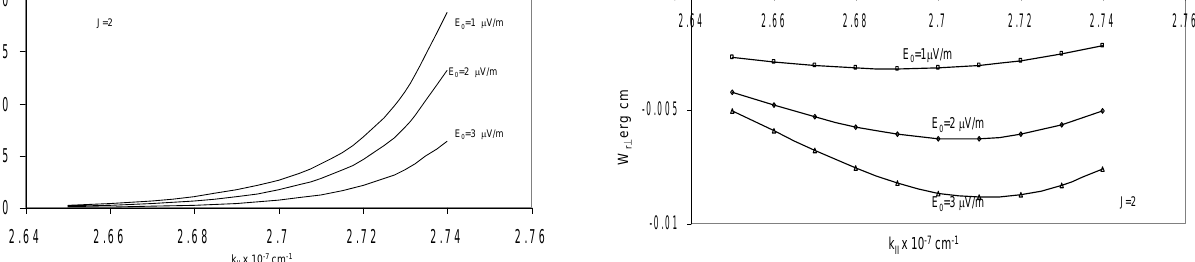
37 40 Fig. 9. Variation of perpendicular resonant energy Wr ⊥ ergcm ver- Fig. 6. Variation of growth rate ( γ / (cid:127) i ) versus wave vector k II Fig:-3 Variation of growth rate( γ / Ω i ) versus w vector k II cm -1 for different values of parallel electric field E 0 ,and distribution index J=2.ave Fig. 6 Variation of growth rate ( γ / Ω ) versus wave vector k i II cm-1 for different values of parallel electric field sus wave vector k II cm − 1 for different values of parallel electric cm − 1 for different values of parallel electric field E 0 , and distribu- Fig:-6 Variation of perpendicular resonant energy W r ⊥ ergcm versus wave vector k II cm -1 for different values of parallel Fig. 9 Variation of perpendicular resonant energy Wr ⊥ ergs-cm versus wave vector k II cm-1 for different values E 0 , and distribution index J=2. of parallel electric field E 0 , and distribution index J = 2. e lectric field E 0 ,and distribution index J=2. field E 0 , and distribution index tion index J=2.